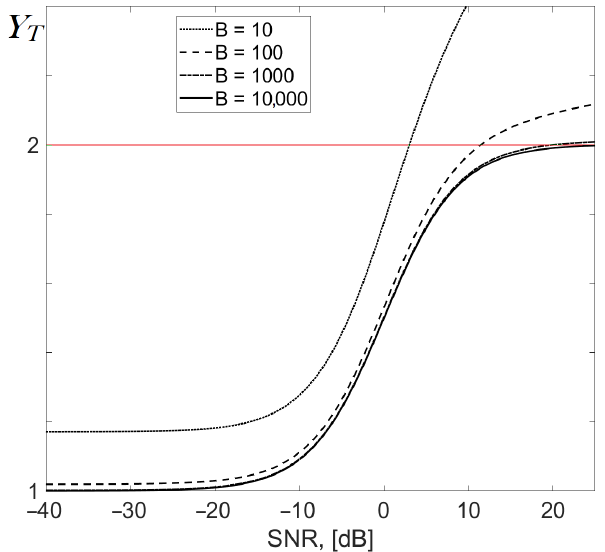
Figure 3. Threshold Y T as a function of SNR for various values of the processing gain B .